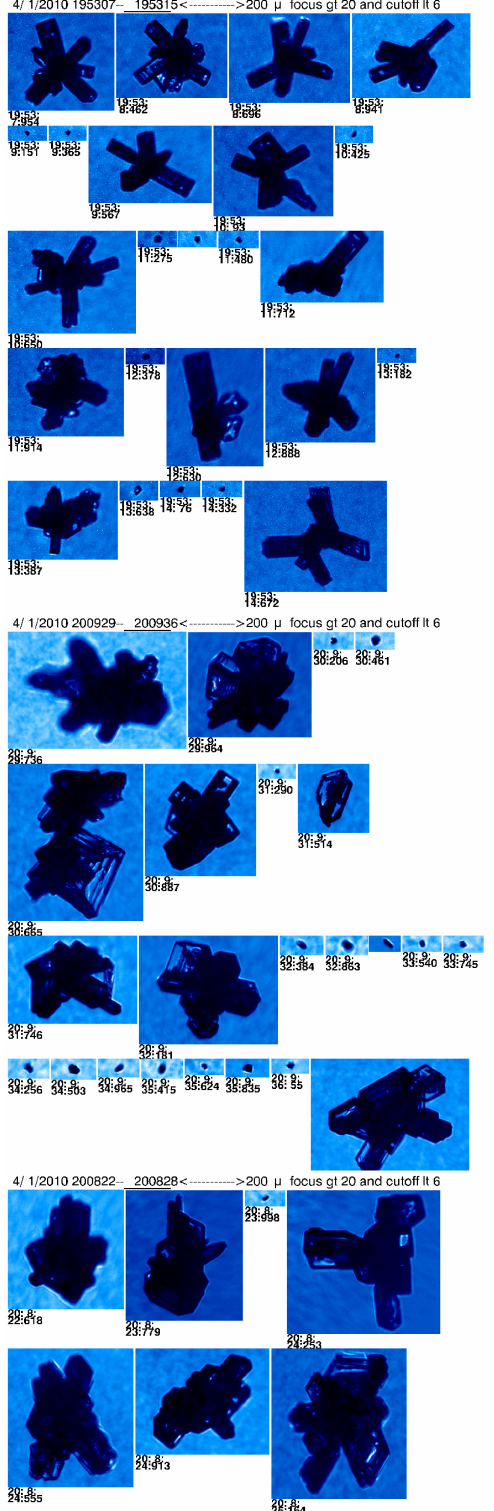
Figure 10. Bullet rosettes and unclassified crystals with radiating growth imaged on 1